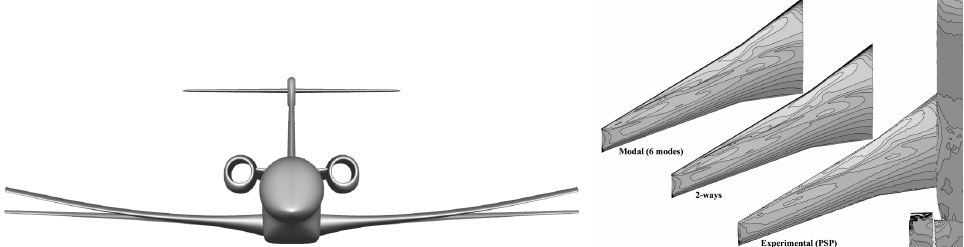
Figure 10. ( Left ): P1XX 2-way deformation amplified 10 times. ( Right ): comparison of suction side pressure for modal, 2-way, and experimental cases [46].